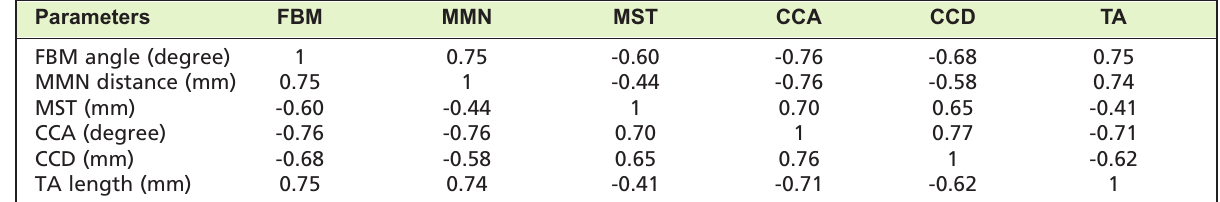
The correlation of foot bimalleolar (FBM) angle with various sonographic parameters and among each other (p-values) Table I: Parameters